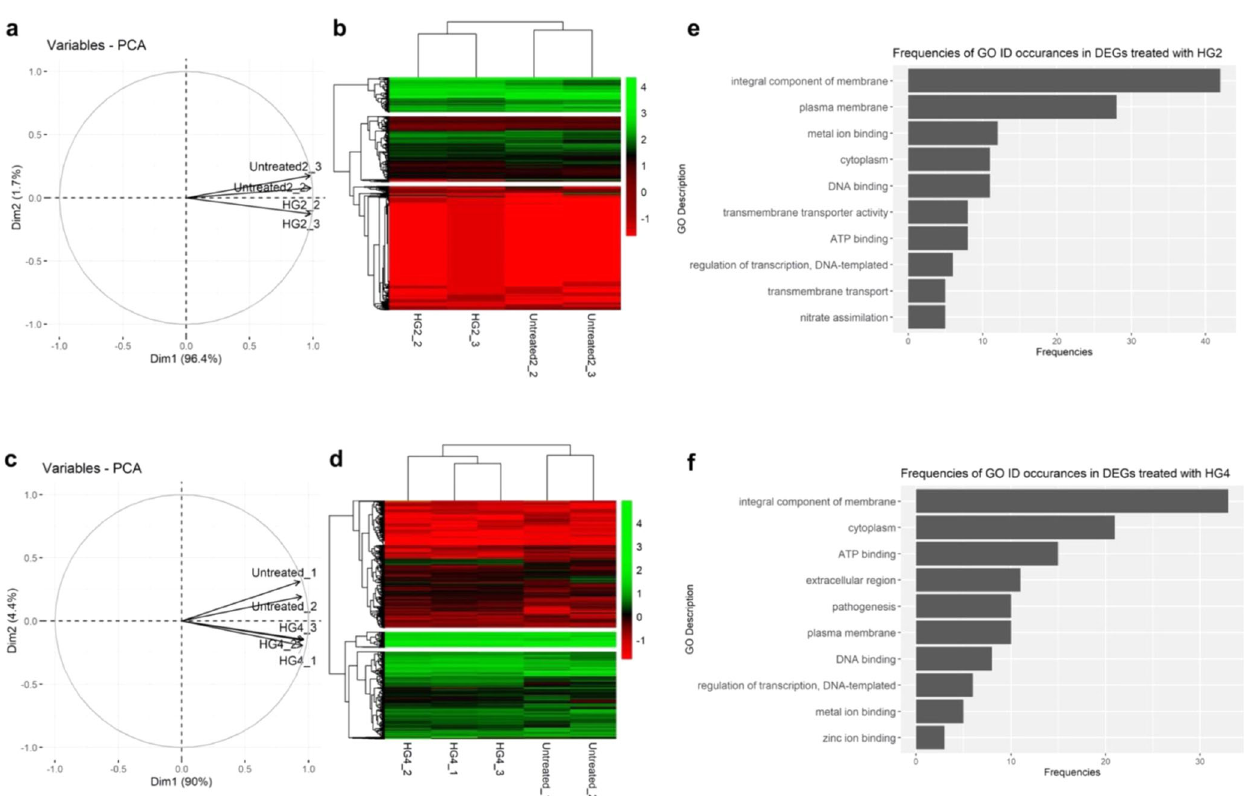
Fig. 7 Peptide-induced transcriptional changes in MRSA USA300 cells. a Principal component plot and b Hierarchical clustering analysis plot in the HG2 treatment group after outlier(s) (HG2_1 and Untreated2_1) removal. c Principal component plot and d Hierarchical clustering analysis plot in the HG4 treatment group after outlier (Untreated_3) removal. Frequencies of top ten Gene Ontology (GO) terms in the DEGs in samples treated with e HG2 and f HG4. In total, 12 samples were sequenced (six per HG2 treatment group i.e., HG2_1, HG2_2, HG2_3, Unt_1, Unt_2 and Unt_3 and six per HG4 treatment group including HG4_1, HG4_2, HG4_3, Unt_1, Unt_2 and Unt_3). As the HG2 treatment experiment, was performed separately from the HG4 treatment experiment with each group having their own distinct untreated sample groups, the analysis of each treatment group was performed